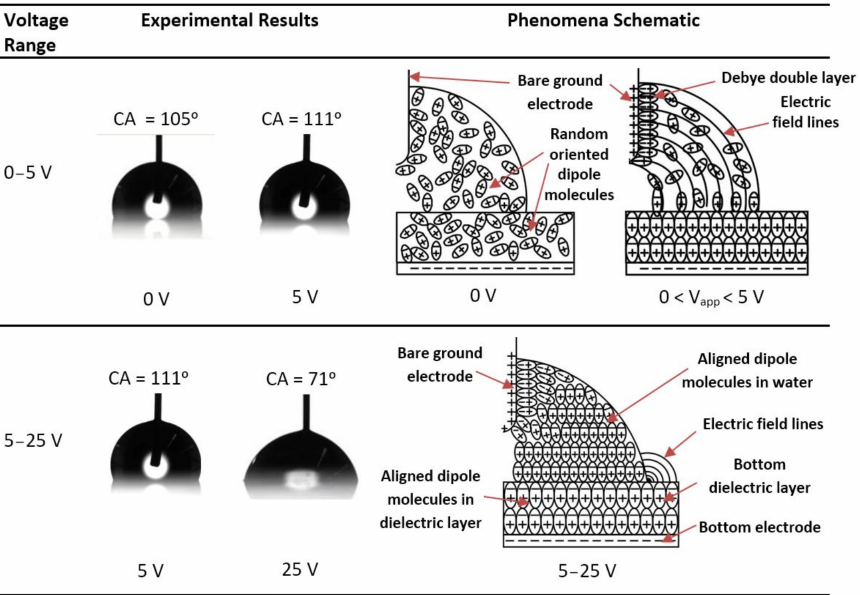
Figure 14. Experimental images and schematics describing the physics of sessile-drop electrowetting with the bare ground electrode and increasing DC